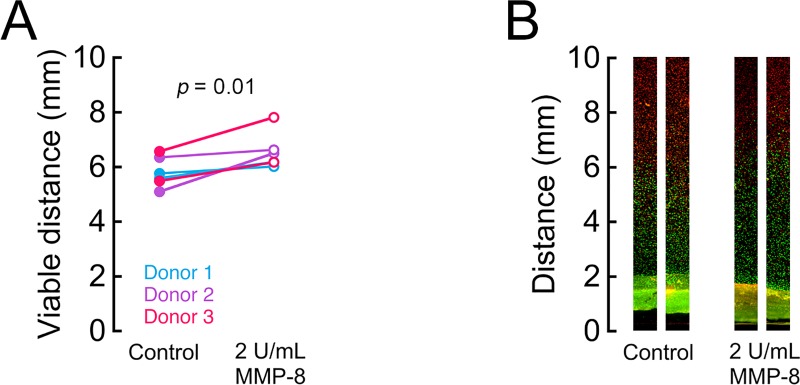
MMP-8 improves nutrient diffusion in CEP tissues.(A) Diffusion chambers containing CEP samples treated for 18 h with 2 U/mL of MMP-8 showed increased viable distance, indicating greater glucose availability. Mean difference: 0.74 mm; 95% CI: 0.23, 1.25, p = 0.01 (B) Representative photomicrographs of the diffusion chamber showing the transition between live (green) and dead cells (red). Distance was measured from the open side of the chamber. Chambers were cultured for 72 h with 4 million NP cells/mL.